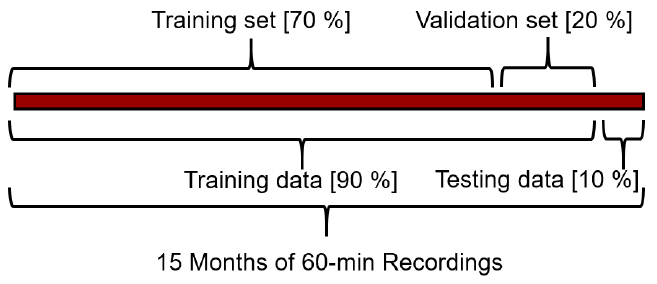
Figure 7. Data division